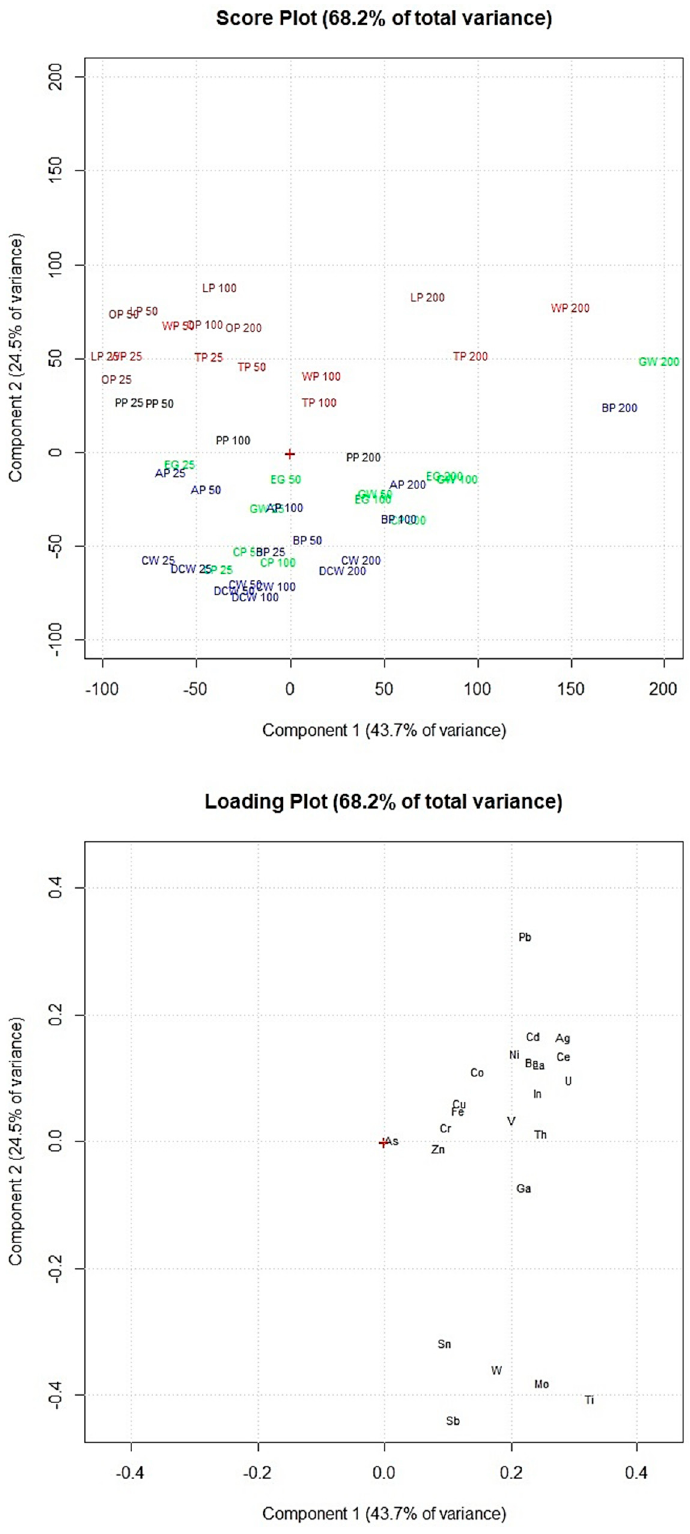
Figure 5. Score plot and loading plot of the PCA performed on the data obtained by the adsorption experiments at pH 2.0. PP, potato peel; LP, lemon peel; OP, orange peel; WP, watermelon peel; TP, tomato peel; CW, coffee waste; AP, apple peel; BP, banana peel; DCW, decaf coffee waste; EG, eggplant peel; CP, carob peel; GW, grape waste; 25, 25 mg of adsorbent; 50, 50 mg of adsorbent; 100, 100 mg of adsorbent; 200, 200 mg of adsorbent.